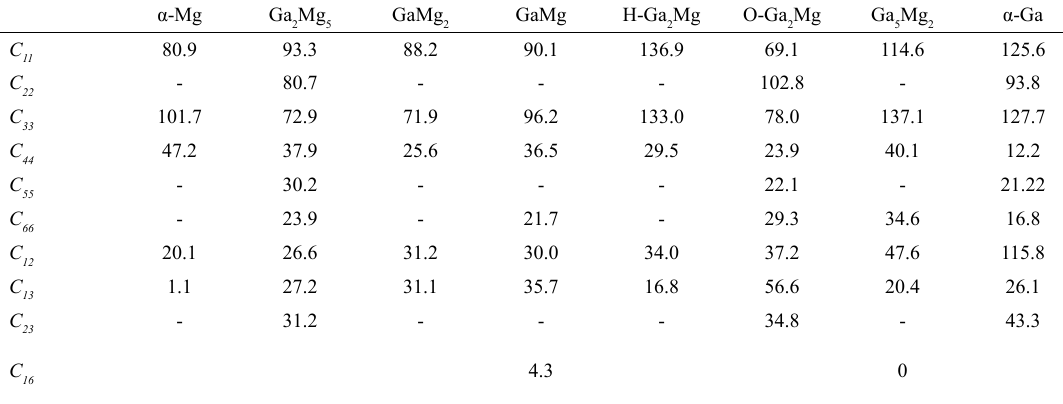
, in GPa) of Ga-Mg ij